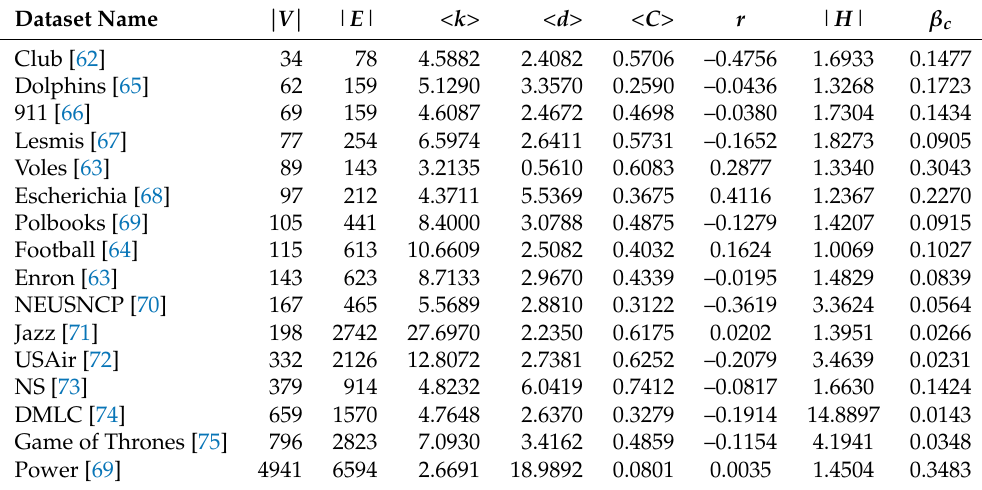
Table 2. Statistics of 16 monolayer network datasets that are utilized in this